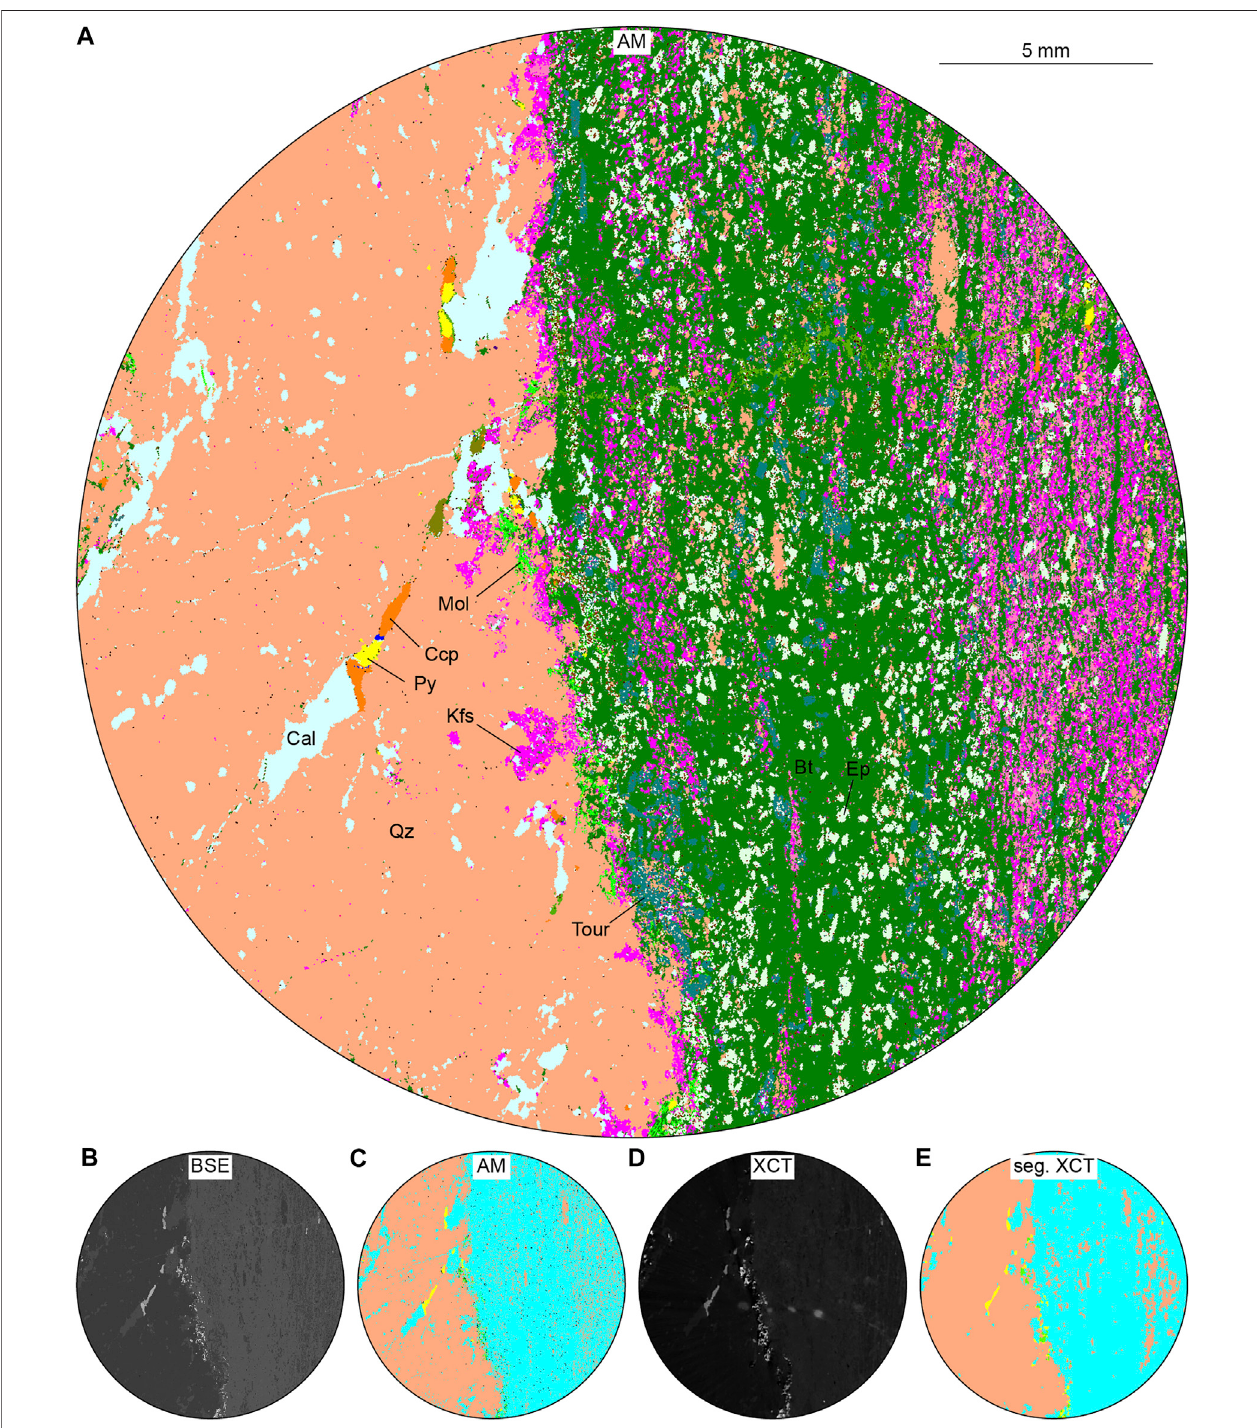
FIGURE 10 | AM and XCT images of a polished rock chip of molybdenite mineralization along the contact between a quartz vein and biotite schist (sample 4). For colorcodingoftheminerals,see Table2 . (A) 30 μ mpixelsizeAMmineralmap. (B) 1.87 μ mpixelsizeAMBSEimage. (C) 30 μ mpixelsizesimpli fi edAMmineralmap. (D) 30 μ mvoxelsizeXCTscan. (E) 30 μ mvoxelsizesegmentedXCTscan.Abbreviations:Bt – biotite,Cal – calcite,Ccp – chalcopyrite,Ep – epidote,Kfs – k-feldspar,Mol – molybdenite, Py – pyrite, Tour – tourmaline, Qz – quartz.